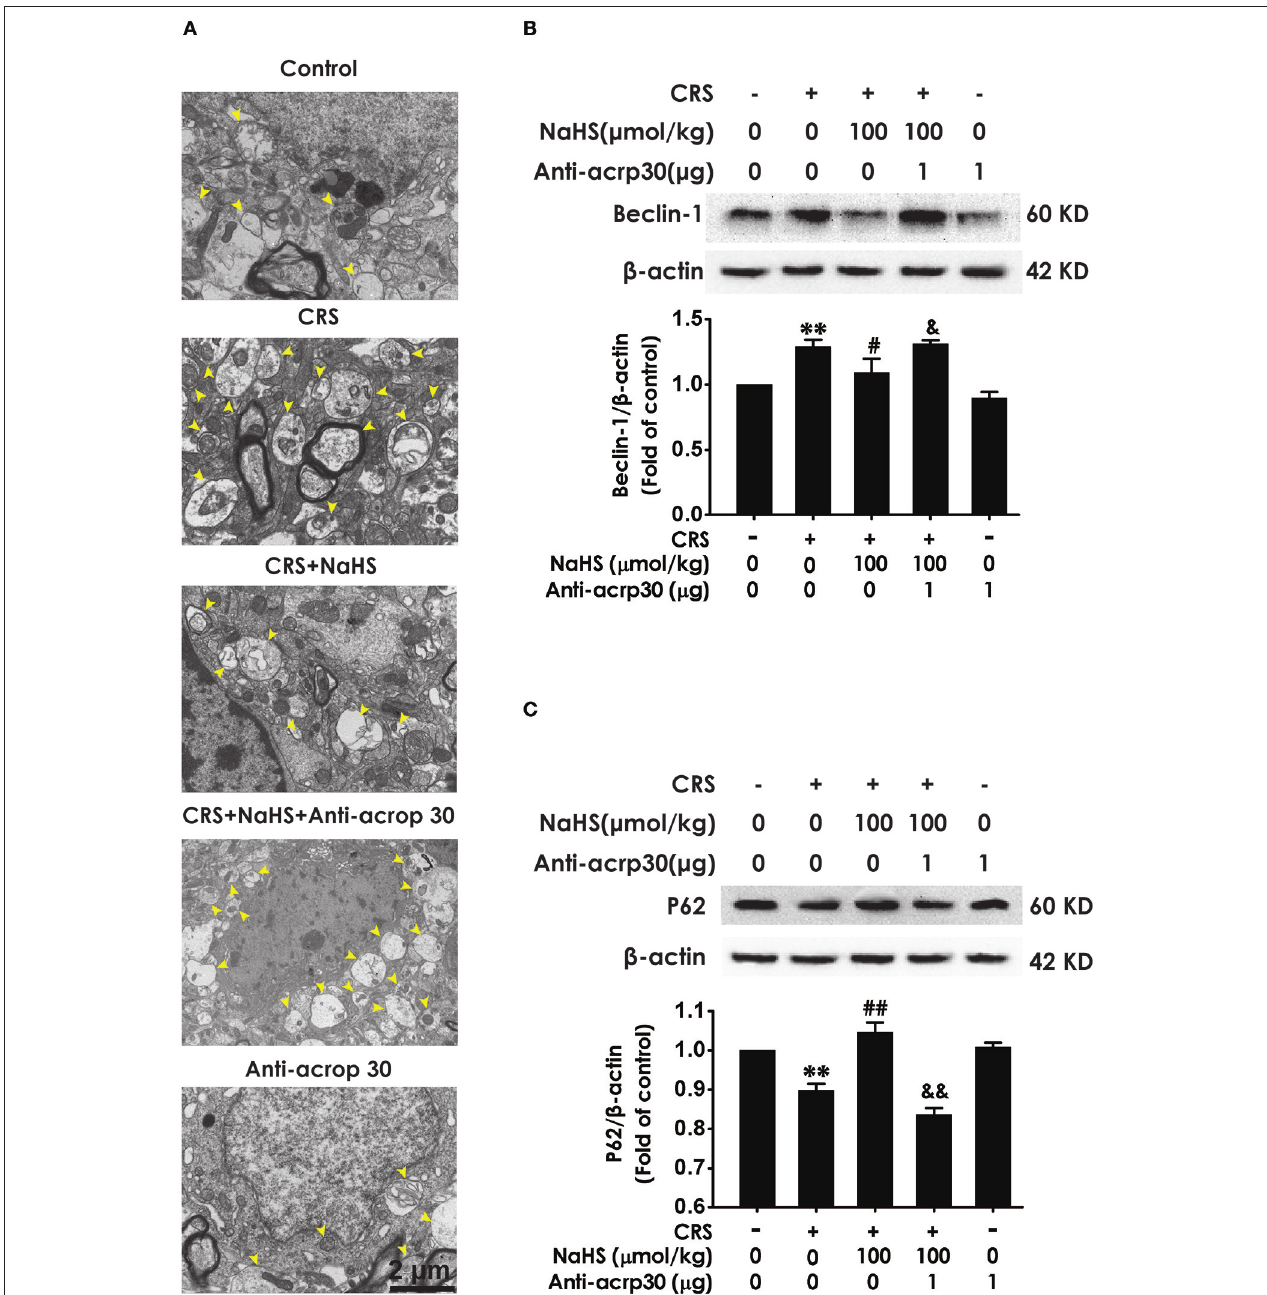
FIGURE 8 | Effect of Anti-acrp30 on H 2 S-elicited suppression in CRS-induced excessive hippocampal autophagy. After cotreatment with CRS and NaHS (100 µ mol/kg, i.p.) for 3w, SD rats were further co-administrated with Anti-acrp30 (1 µ g/d, icv) for 1w. The number of hippocampal autophagosomes (A) was detected under transmission electron microscopy. The arrowhead marked autophagosomes. The expression of beclin1 (B) and P62 (C) in the hippocampus were detected by western blot and β -actin was used as an internal control. Values are expressed as means ± SEM ( n = 3). ** P < 0.01, vs. control group; # P < 0.05, ## P < 0.01, vs. CRS-treated alone group, & P < 0.05, && P < 0.05, vs. cotreatment with CRS and NaHS (100 µ mol/kg, i.p.)